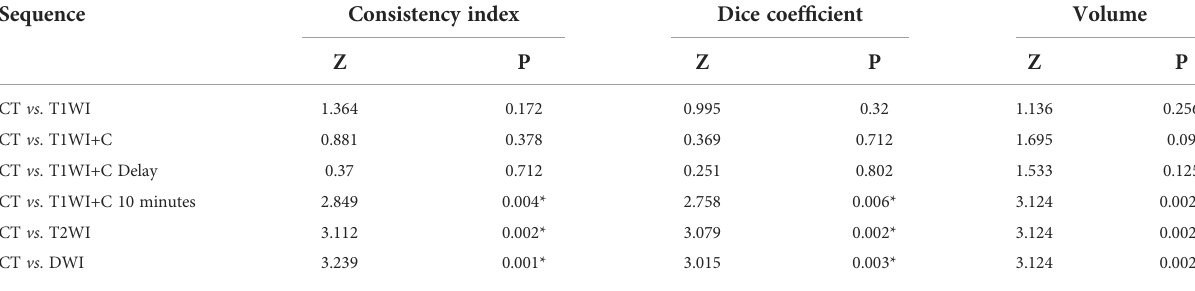
TABLE 3 The results of the Wilcoxon rank-sum test of mean volumes, CI, and